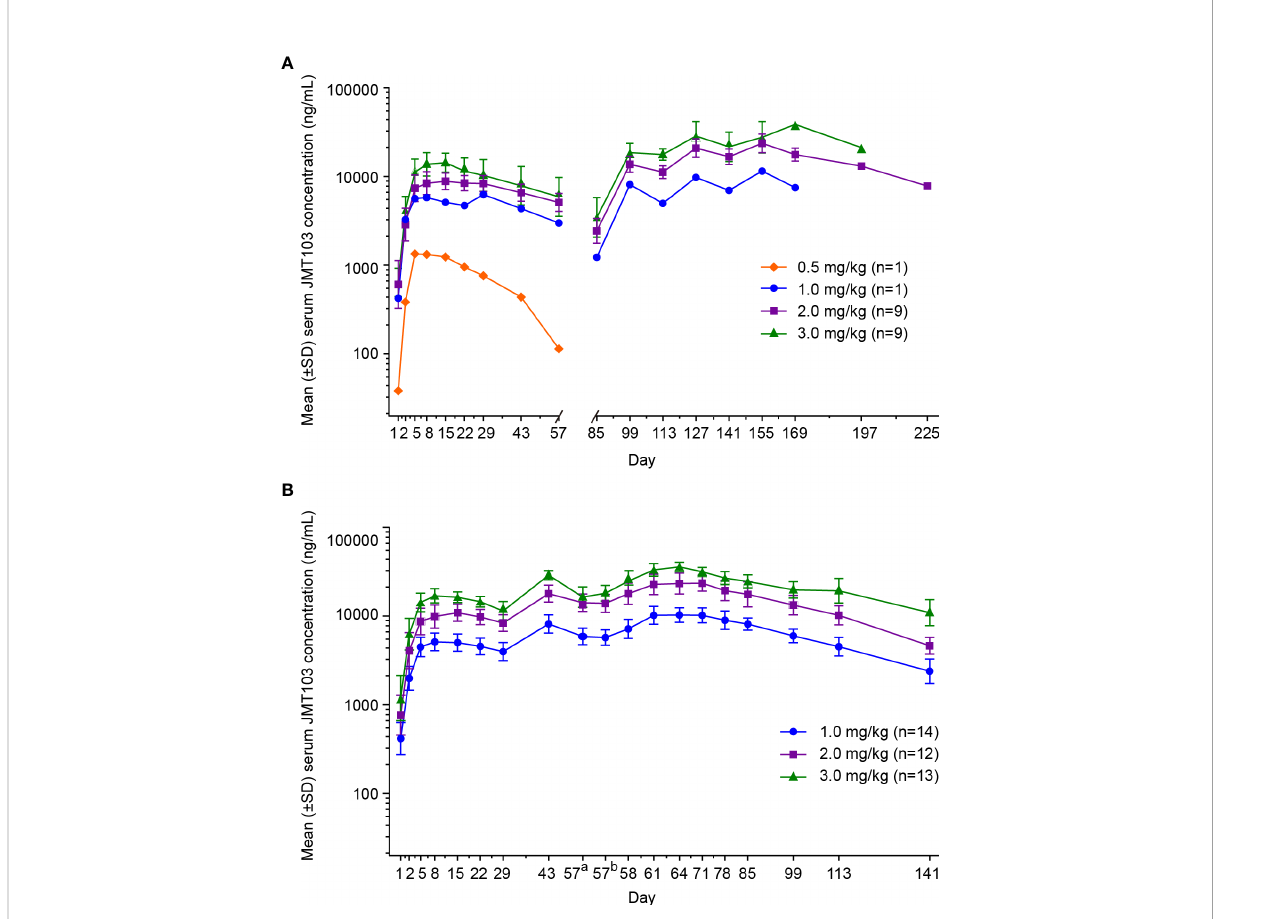
FIGURE 2 Mean concentration-time pro fi les following subcutaneous administration of JMT103 in patients with bone metastasis from solid tumors. (A) Serum concentration-time pro fi le of JMT103 after single-dose administration; (B) serum concentration-time pro fi le of JMT103 after multiple- dose administration. SD, standard deviation. a means pre-dose; b means